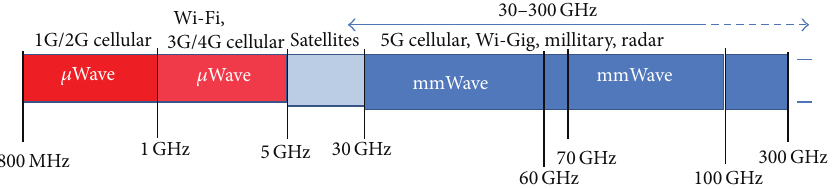
Figure 2: An overview of the mm-Wave Spectrum for future multiantenna wireless